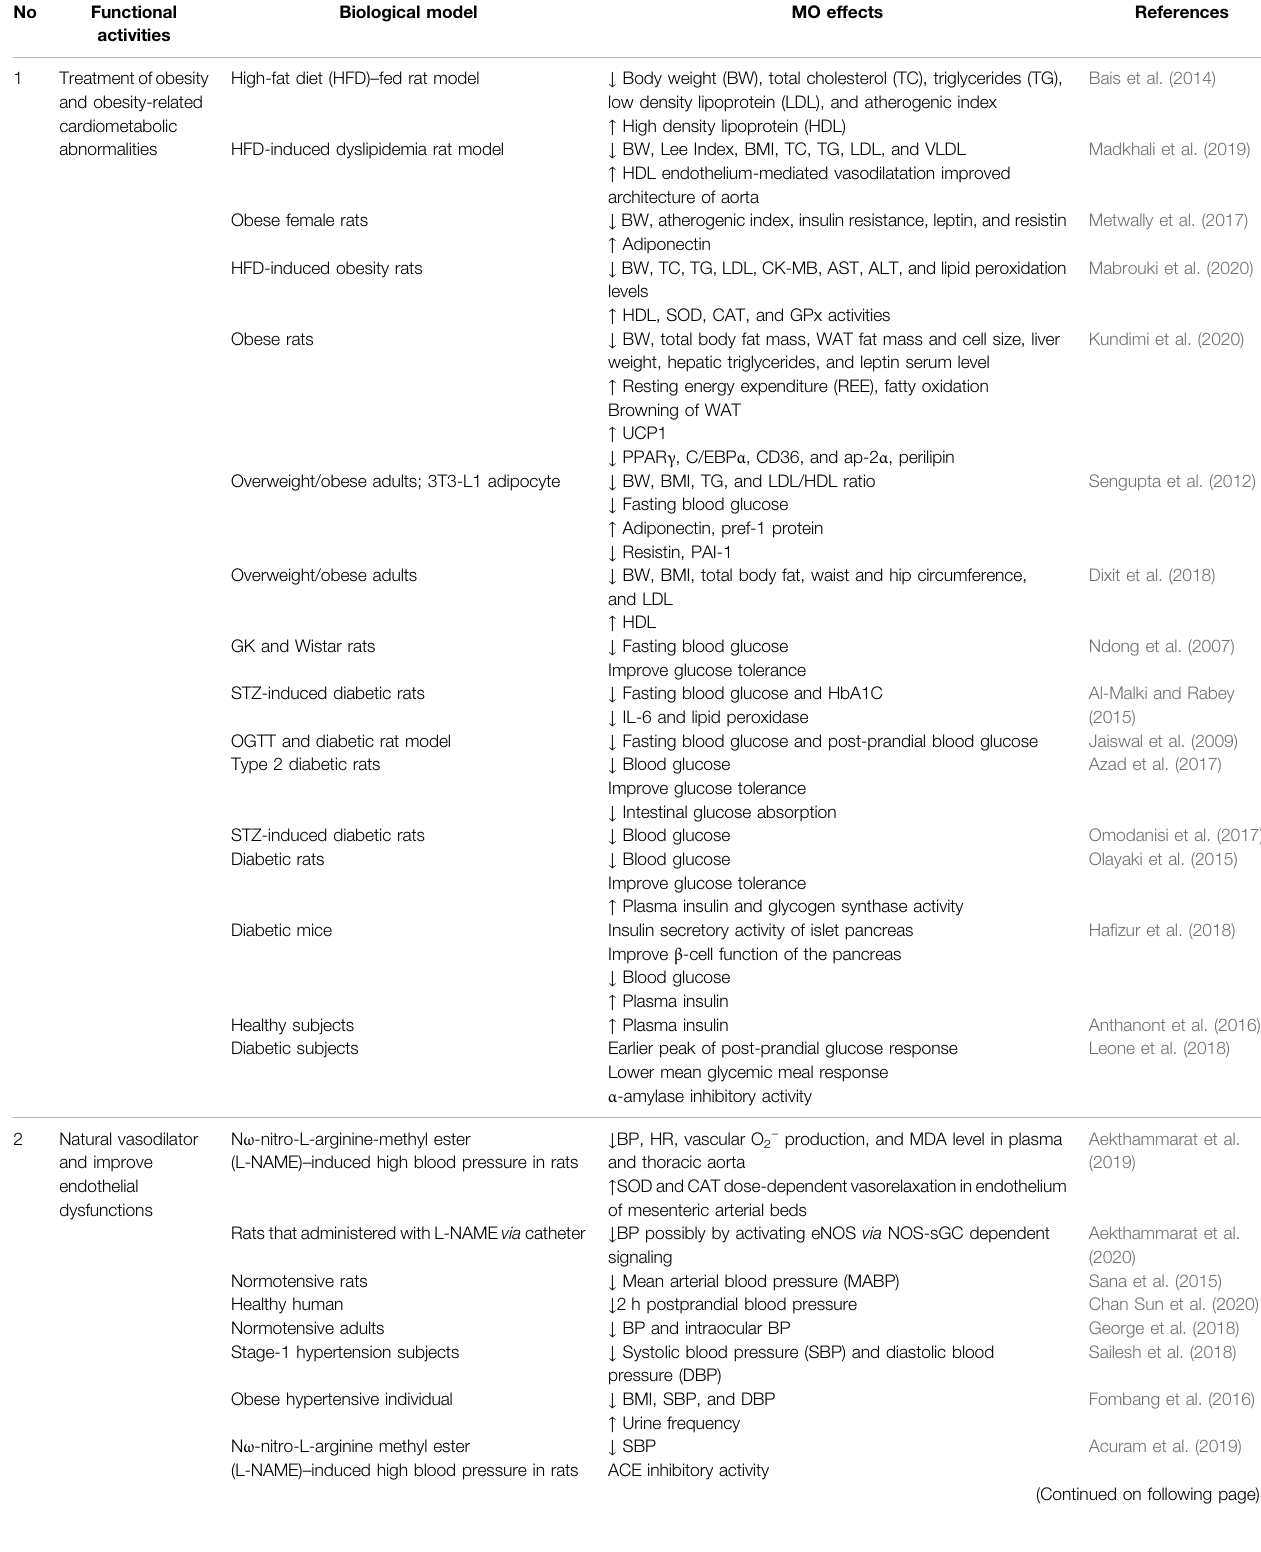
TABLE 4 | Functional activities of Moringa oleifera in CVD fi